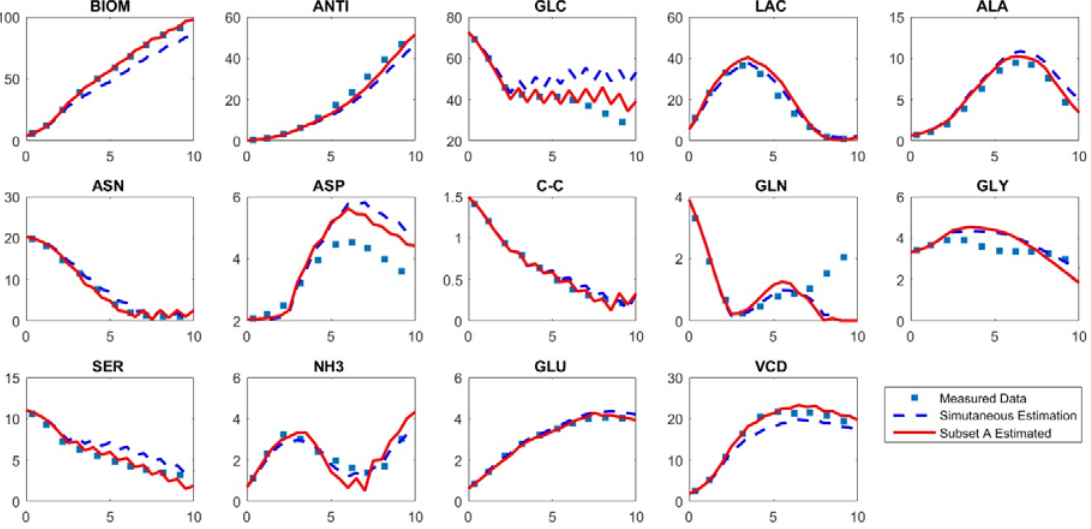
Figure 4. Comparison between predictions by the new model with 4 most sensitive parameters estimated ( ― ) with predictions by the model with all parameters estimated simultaneously (--). The experimental data from [4] are shown, as well ( ). The x-axis is the culture time in days and y-axis is the concentration in mM, except for the viable cell density (VCD) which is 10 (cid:2874) cells/mL.